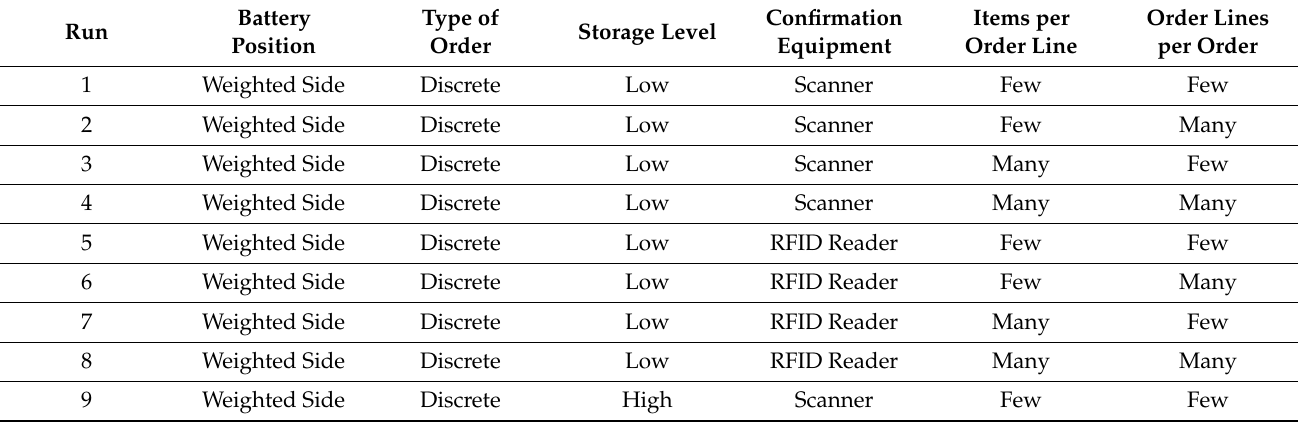
Table 5. The design